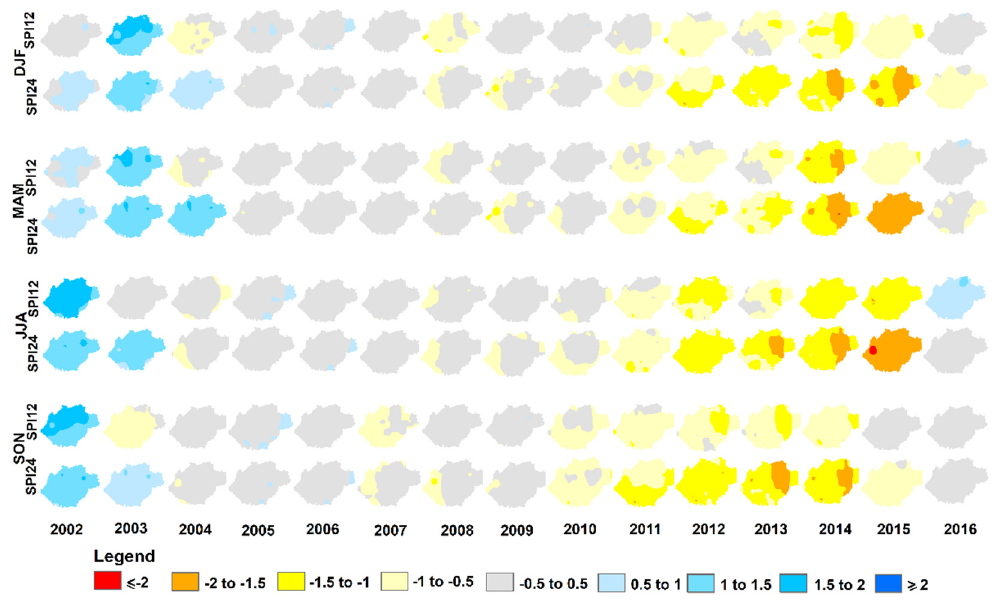
Figure 6. Standardized Precipitation Index (SPI) time series from 1982 to 2017, ( a ) SPI1, ( b ) SPI3, ( c ) SPI6, ( d ) SPI9, ( e ) SPI12, and ( f ) SPI24.